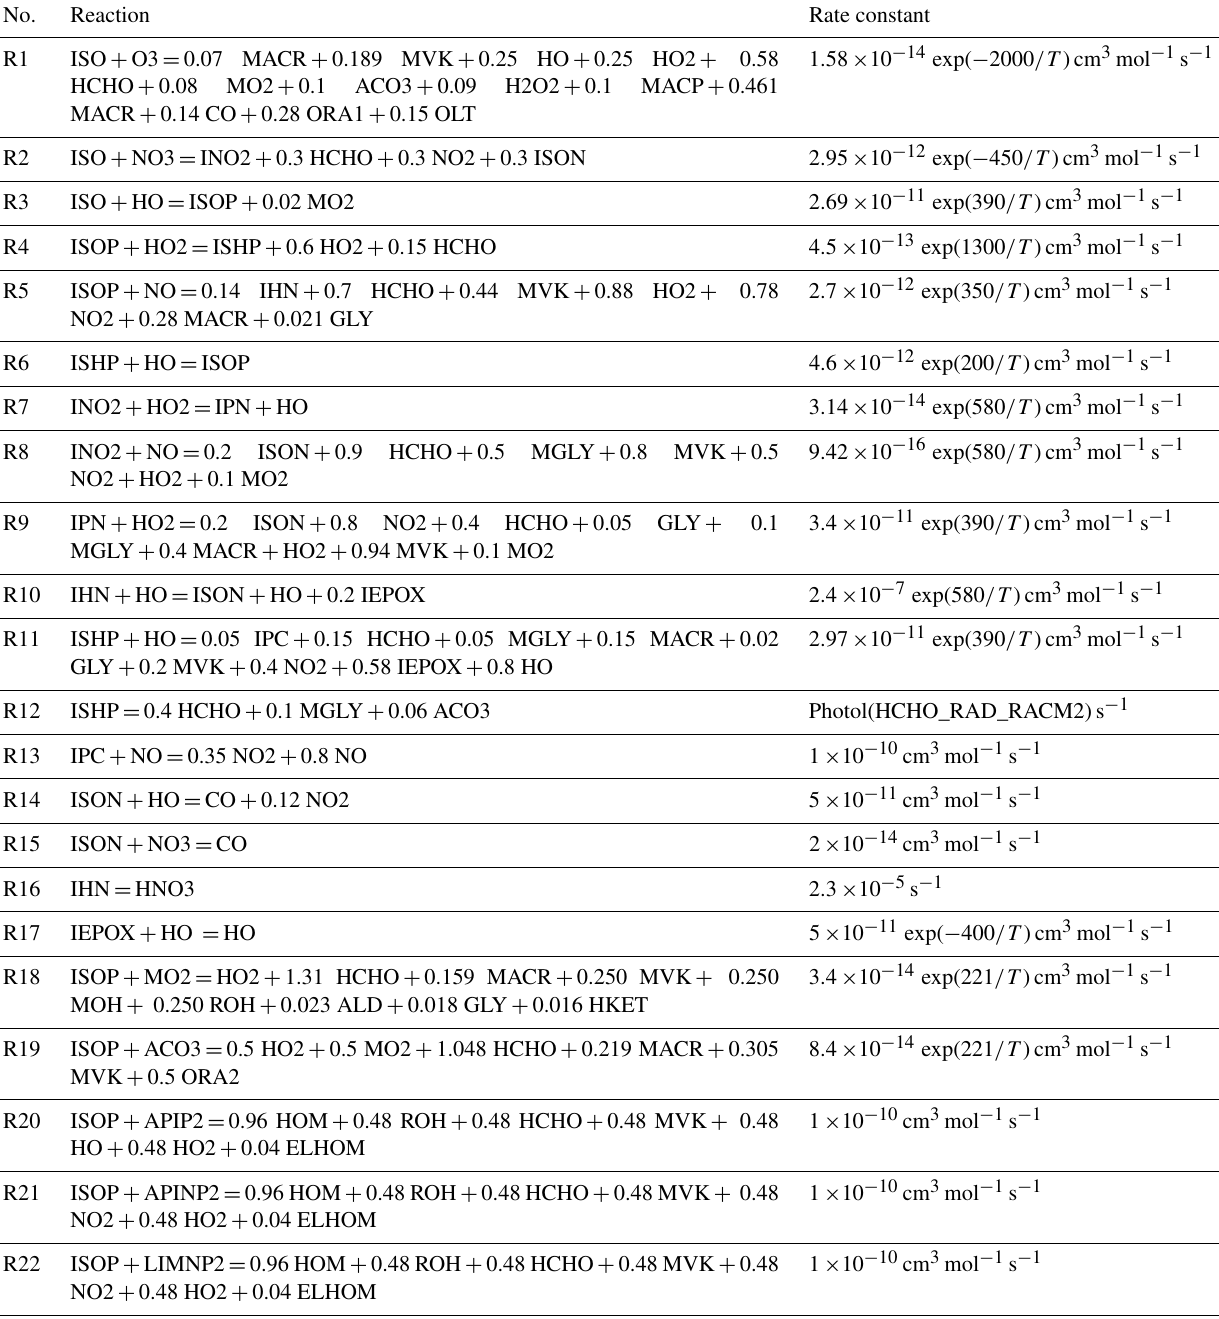
Table 4. The AMORE-Isoprene mechanism reactions and rate constants. Mechanism-specific species are listed in the text. No. Reaction Rate constant R1 ISO + O3 = 0.07 MACR + 0.189 MVK + 0.25 HO + 0.25 HO2 + 0.58 HCHO + 0.08 MO2 + 0.1 ACO3 + 0.09 H2O2 + 0.1 MACP + 0.461 MACR + 0.14 CO + 0.28 ORA1 + 0.15